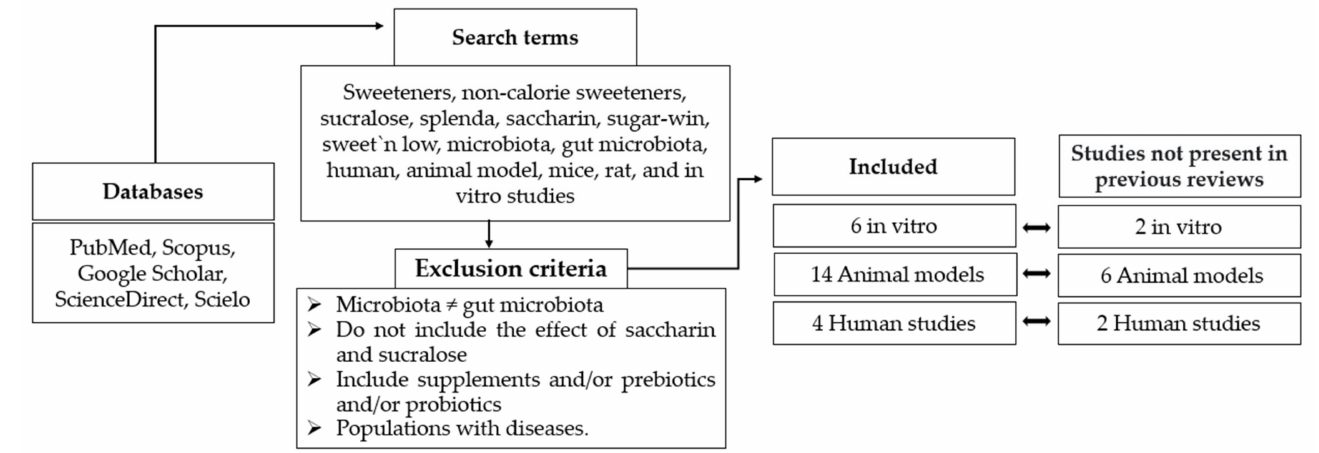
Figure 1. Flow chart regarding selection method.